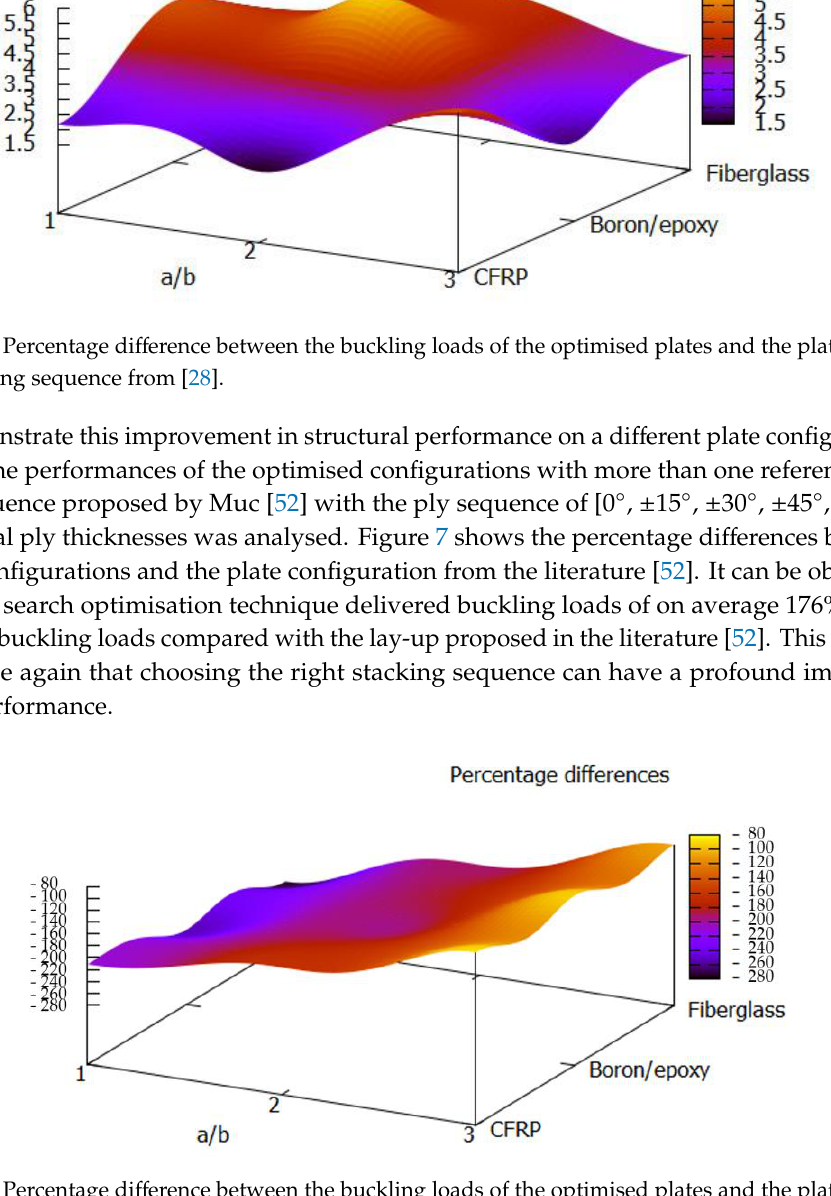
Figure 7. Percentage difference between the buckling loads of the optimised plates and the plates with the stacking sequence from [52].